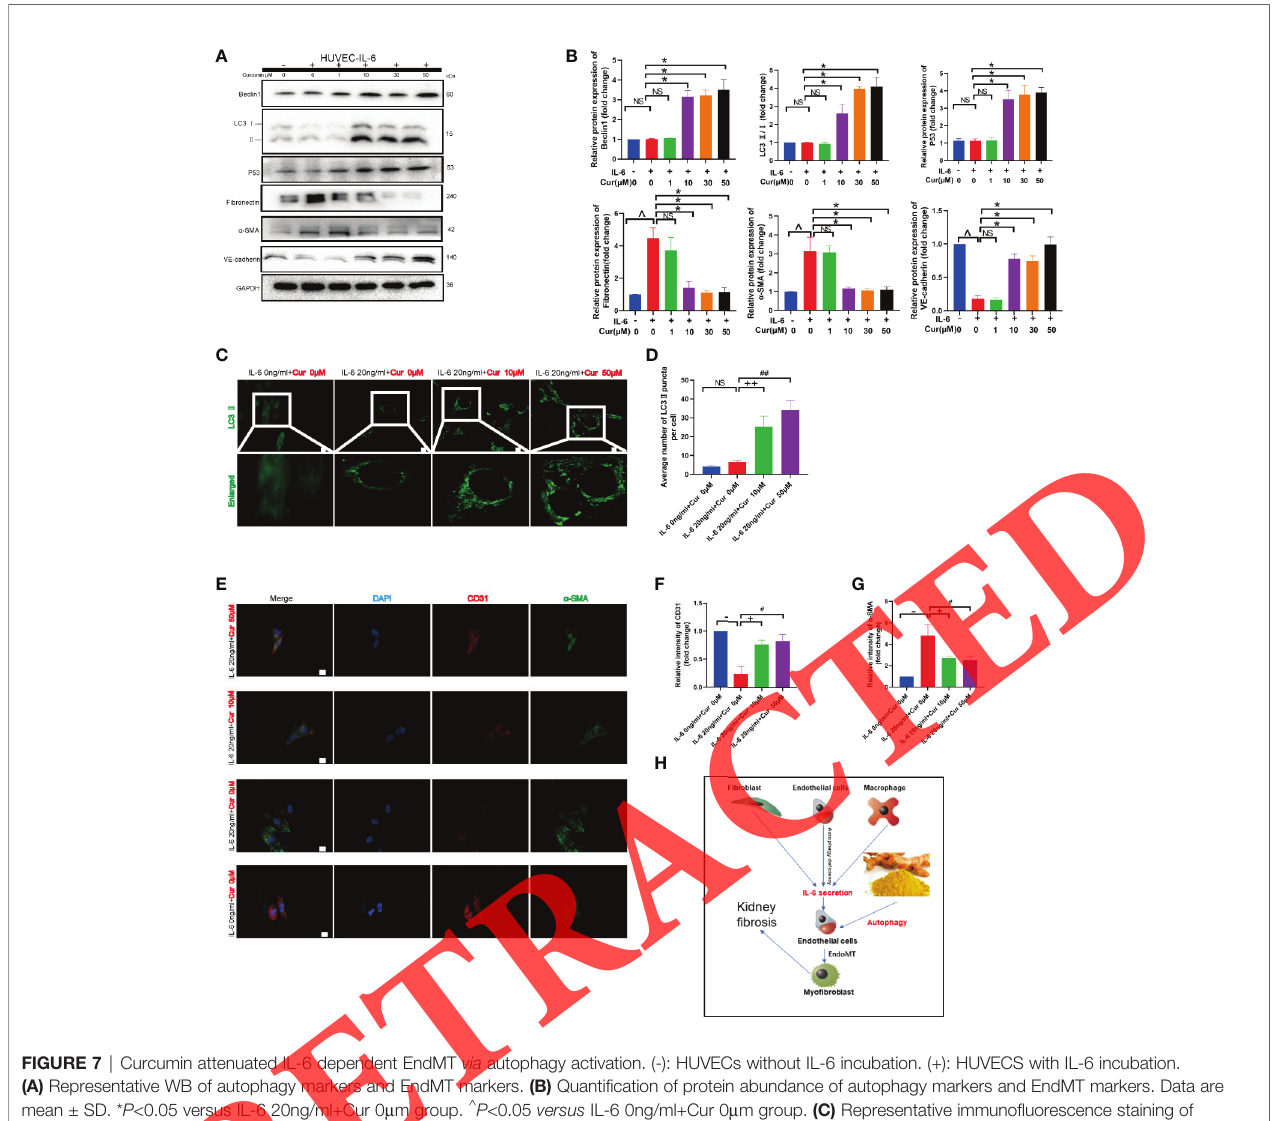
FIGURE 7 | Curcumin attenuated IL-6 dependent EndMT via autophagy activation. (-): HUVECs without IL-6 incubation. (+): HUVECS with IL-6 incubation. (A) Representative WB of autophagy markers and EndMT markers. (B) Quanti fi cation of protein abundance of autophagy markers and EndMT markers. Data are mean ± SD. * P <0.05 versus IL-6 20ng/ml+Cur 0 m m group. ^ P <0.05 versus IL-6 0ng/ml+Cur 0 m m group. (C) Representative immuno fl uorescence staining of LC3 II in HUVECs. Bar=20 m m. (D) Quanti fi cation of average number of LC3 II puncta. Data are mean ± SD of fi ve independent experiments. ++ P <0.01 versus IL-6 20ng/ml+Cur 10 m m group. ## P <0.01 versus IL-6 20ng/ml+Cur 50 m m group. (E) Curcumin inhibited HUVECs transition to EndMT phenotype. Representative immuno fl uorescence staining of CD31 and a -SMA in HUVECs. Bar=20 m m. (F, G) Quanti fi cation of relative intensity of CD31 and a -SMA. Data are mean ± SD of fi ve independent experiments. * P <0.05 versus IL-6 20ng/ml+Cur 10 m m group. # P <0.05 versus IL-6 20ng/ml+Cur 50 m m group. (H) A model is proposed to illustrate the fi brotic mechanism involved in EndMT induced by IL-6 in the pathogenesis of allogeneic kidney interstitial fi brosis and the therapeutic mechanism of Curcumin. NS, not signi fi